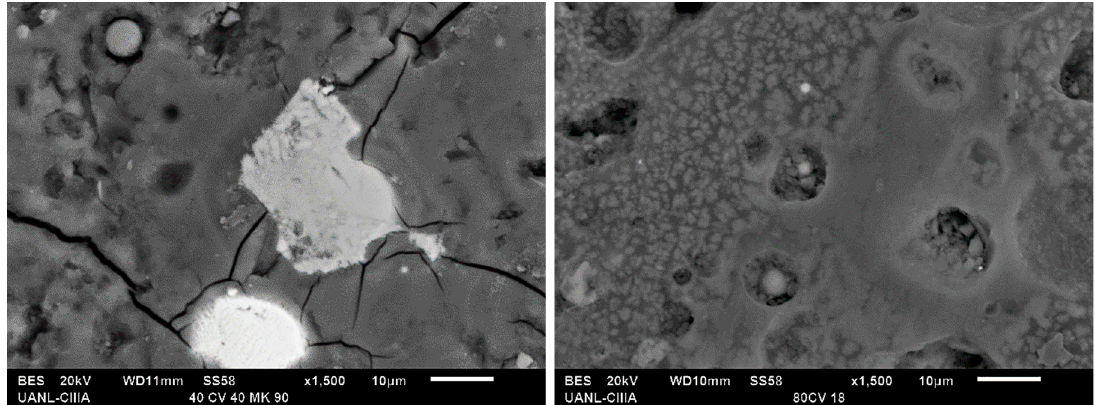
Figure 6. Fly ash particles in the pores of the cementitious matrix.